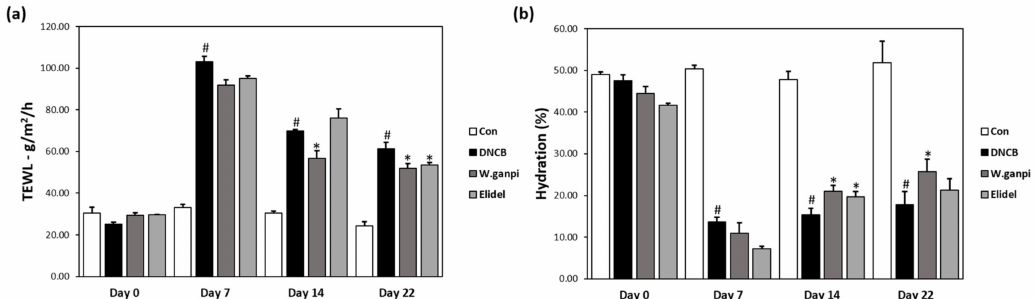
Figure 6. Effects of WGE on the skin barrier function in AD-like symptoms induced by DNCB in hairless mice. ( a ) Transepidermal water loss (TEWL); ( b ) Skin hydration value. # p < 0.05 vs. the CON group; * p < 0.05 vs. the DNCB group.